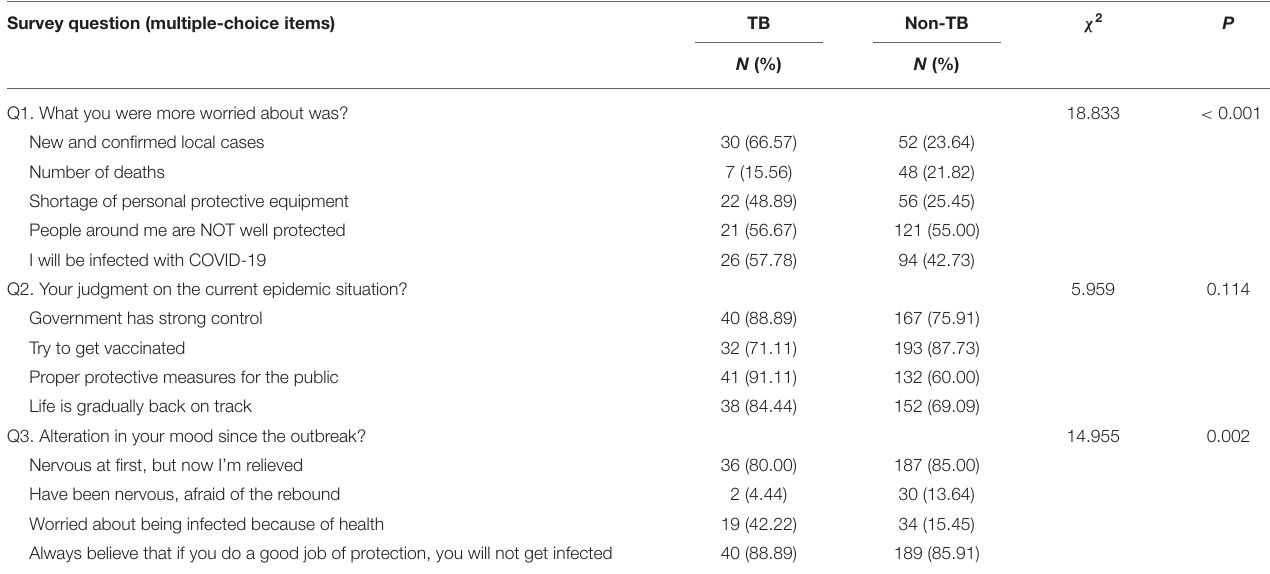
TABLE 3 | Risk perception and emotional reaction